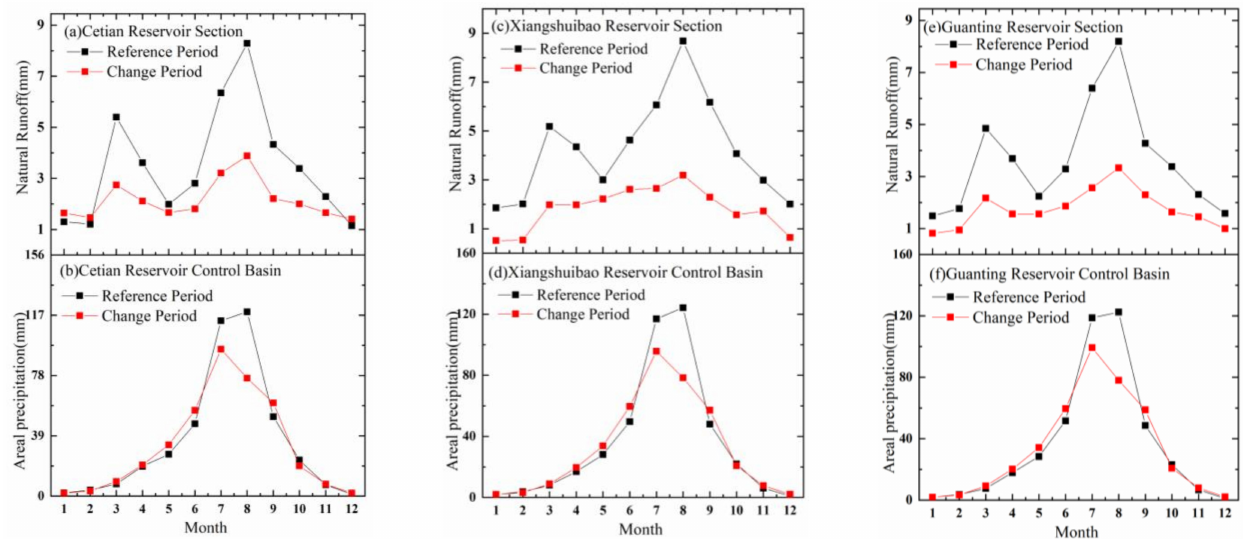
Figure 5. Annual distribution of natural runoff and areal rainfall in the mountain area of Yongding River in different periods. ( a , b ) the natural runoff and areal precipitation of the control basin of Cetian reservior; ( c , d ) the natural runoff and areal precipitation of Xiangshuibao reservior; ( e , f ) the natural runoff and precipitation of the areal control basin of Guanting